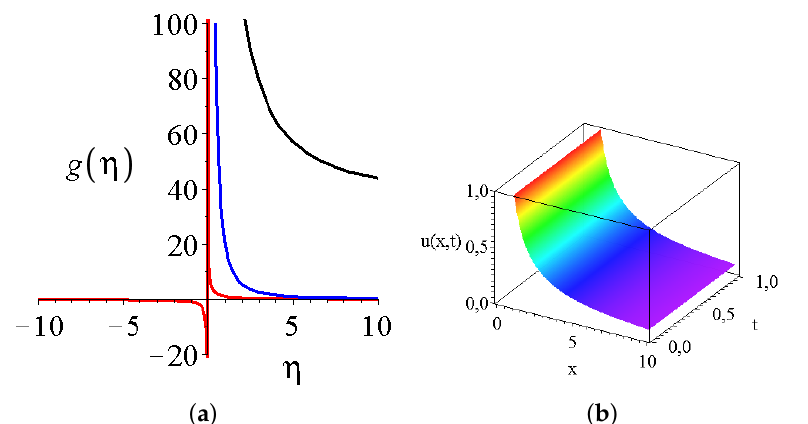
Figure 8. The shape function and the solution for the spatial and temporal dependence of the x component of the wave velocity. ( a ) the shape function of the x velocity component g ( η ) for three α exponents for the time-dependent seabed function. The black, red and blue lines correspond to α = − 1,0 and 1 values, respectively. The integral constants are c 1 = c 2 = c 3 = 1 and the geometrical constants remain the same as above. ( b ) the spatial and temporal dependence of velocity component u ( x , y = 0, t ) for α =